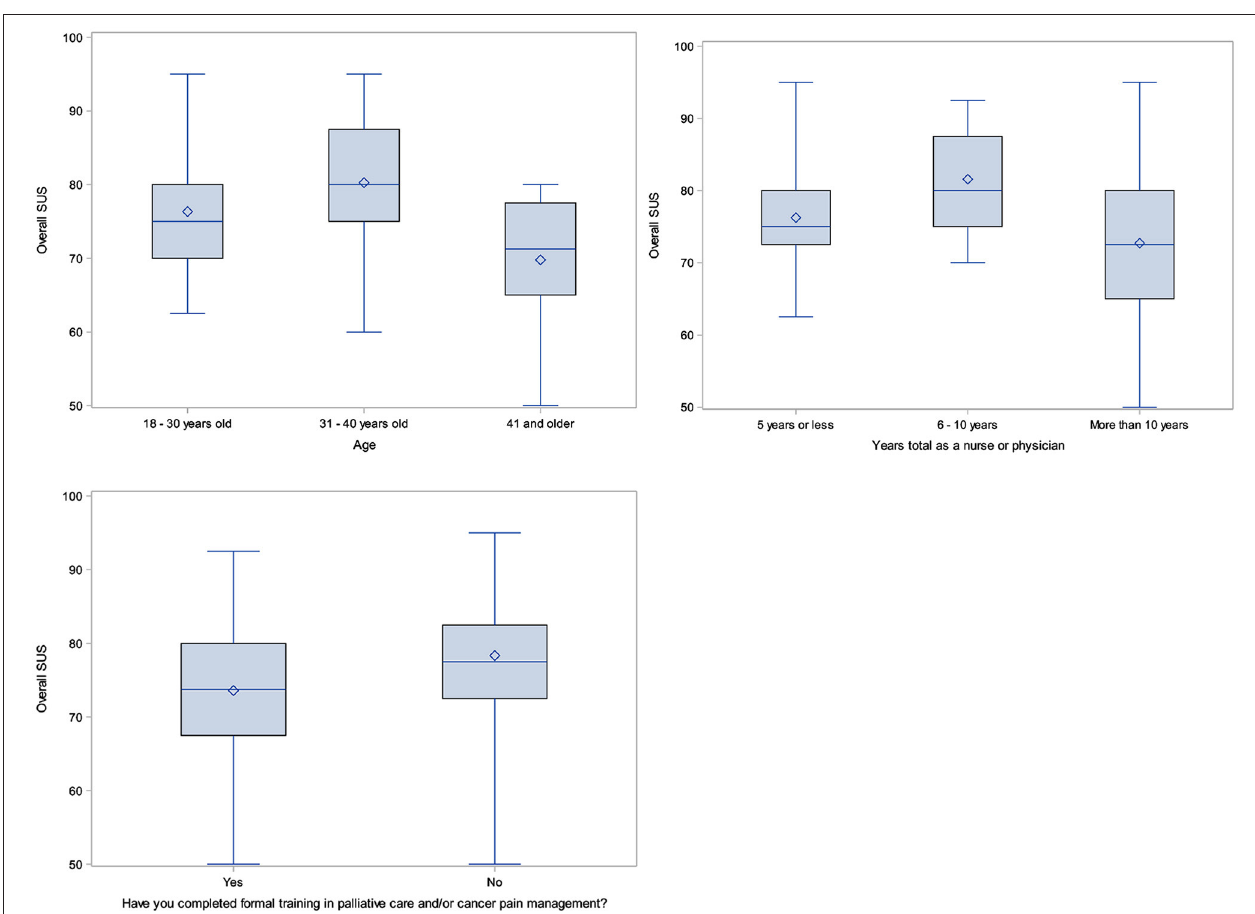
FIGURE 6 | Boxplots of statistically significant variables in final multivariate SUS